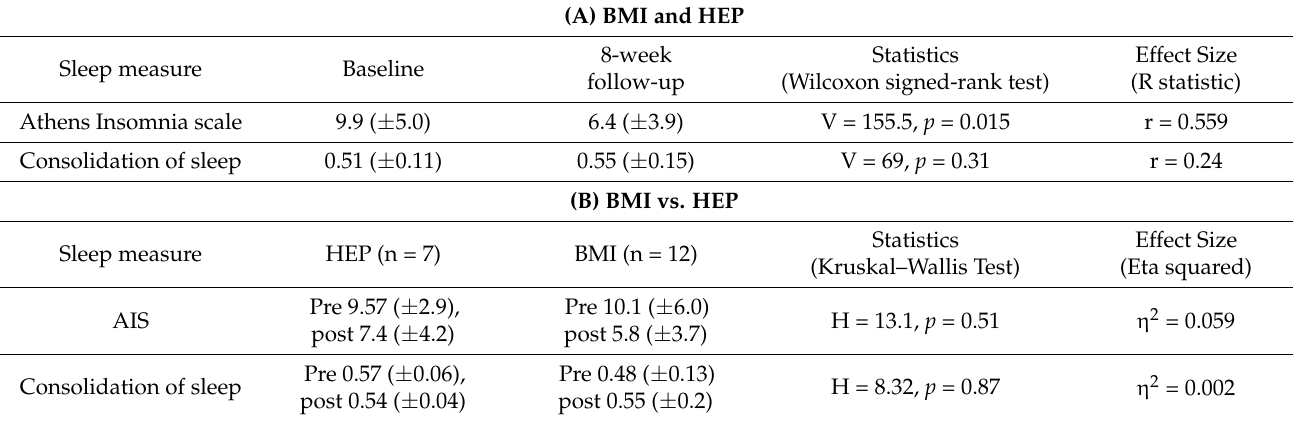
Table 1. Effects of Brief Mindfulness Intervention (BMI) and Health Enhancement Program (HEP) on Athens Insomnia Scale (AIS) and consolidation of sleep (ConDI) (n =